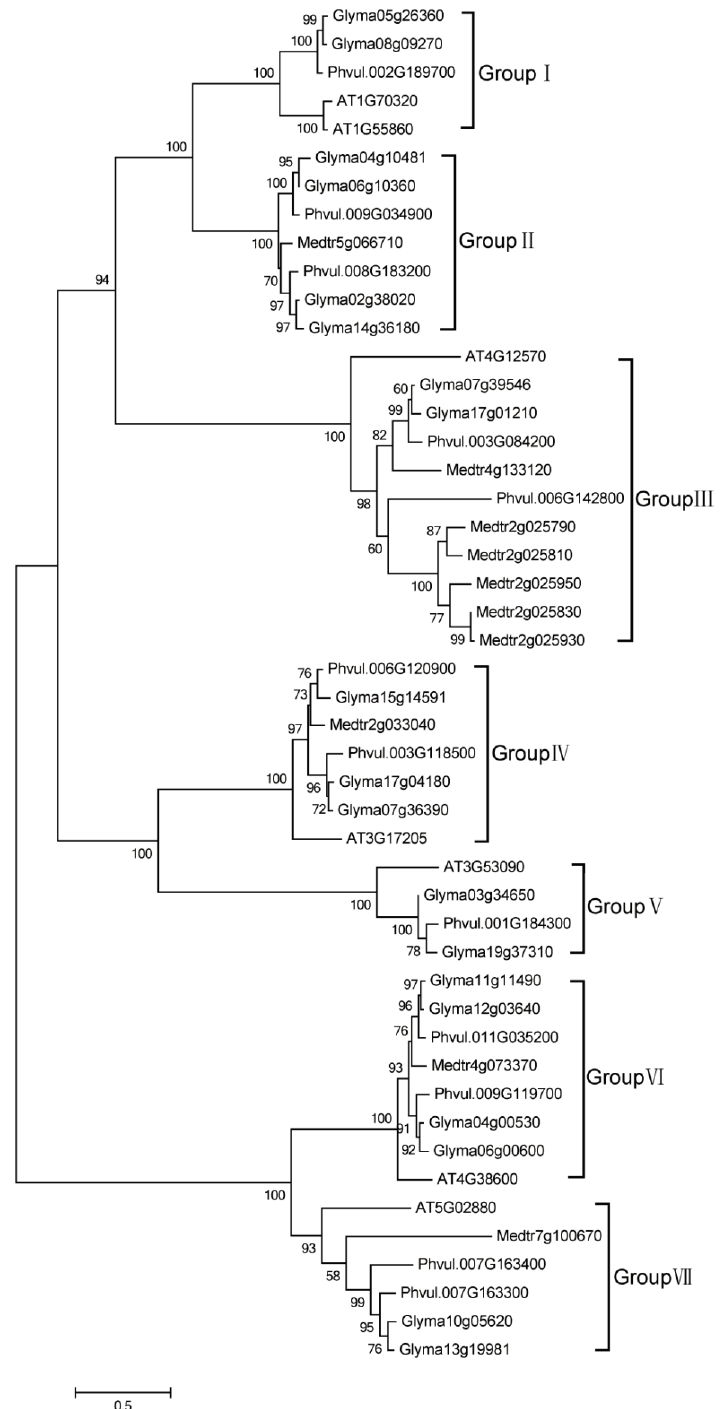
Figure 2. Neighbor-joining (NJ) tree of HECT genes from Glycine max , Medicago truncatula , Phaseolus vulgaris , and Arabidopsis thaliana . MEGA6 package was used to construct the NJ tree from the full-length amino acid sequence alignments (File S2) of the four plant species, with 1000 bootstrap replicates. Numbers refer to bootstrap support (in terms of